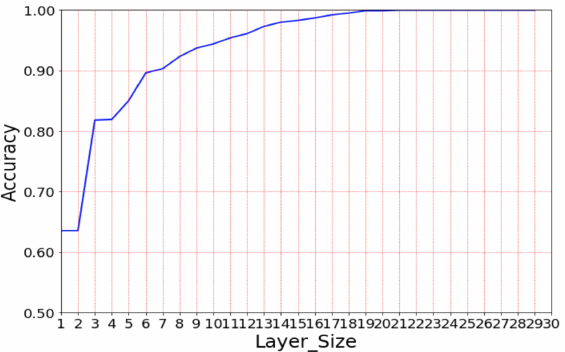
Figure 7. Convergence of accuracy over the different layer sizes of the DTBDNN model.